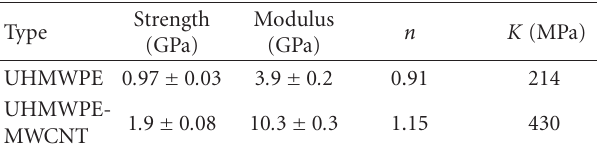
Table 2: Data after strain hardening